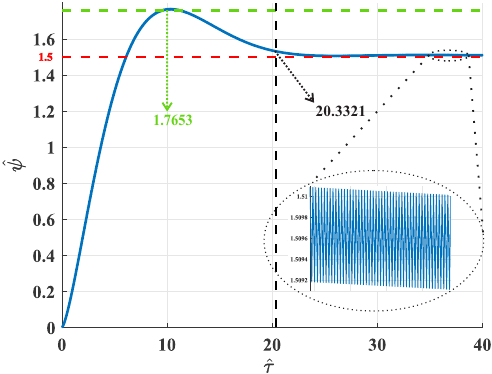
Figure 7. Nondimensionalized capacitor voltage with α = 0.7. The red dotted line represents the voltage reference value set in 1.5. The green dotted line represents the maximum peak reached by the converter, which has a value of 1.7653 that translates into an overshoot of 17.6854%. The black dotted line corresponds to the reached settling time by this device, which is equal to ˆ t ss = 20.3321, using the criterion of 5%. Note that in the lower right part of Figure 7, a zoomed version of the output voltage ripple response is located after achieving the stable state. Such an output ripple ranges between 0.5100 and 0.5092. It is noteworthy that these values are nondimensionalized, and to have the expected values with real units, we must use the reconversion described in (7).